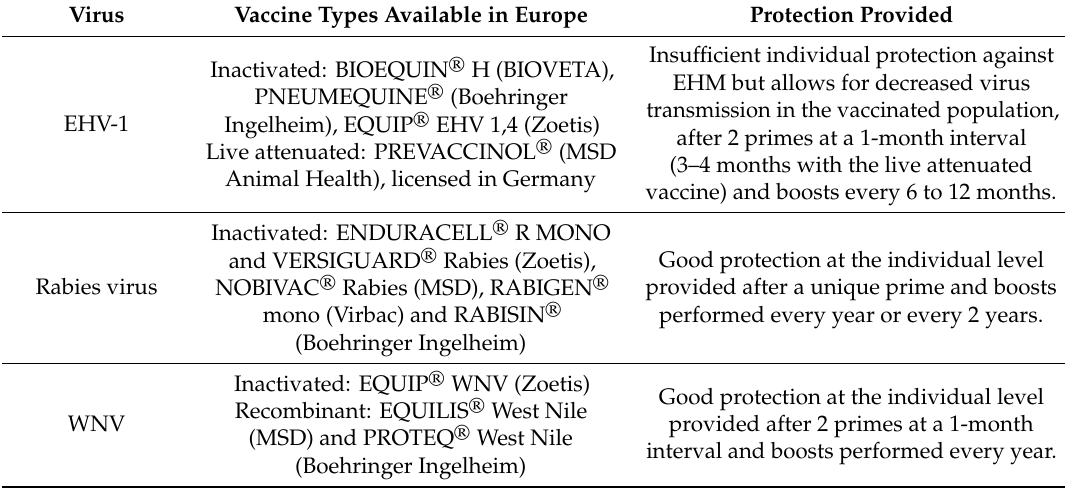
Table 2. List of vaccines licensed in Europe against equine neuropathogenic viruses. Vaccine types and recommended vaccination protocols are